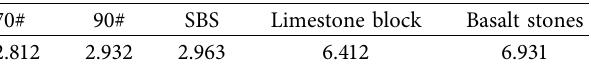
Table 2: Average value of the dielectric constant of the single-phase materials.